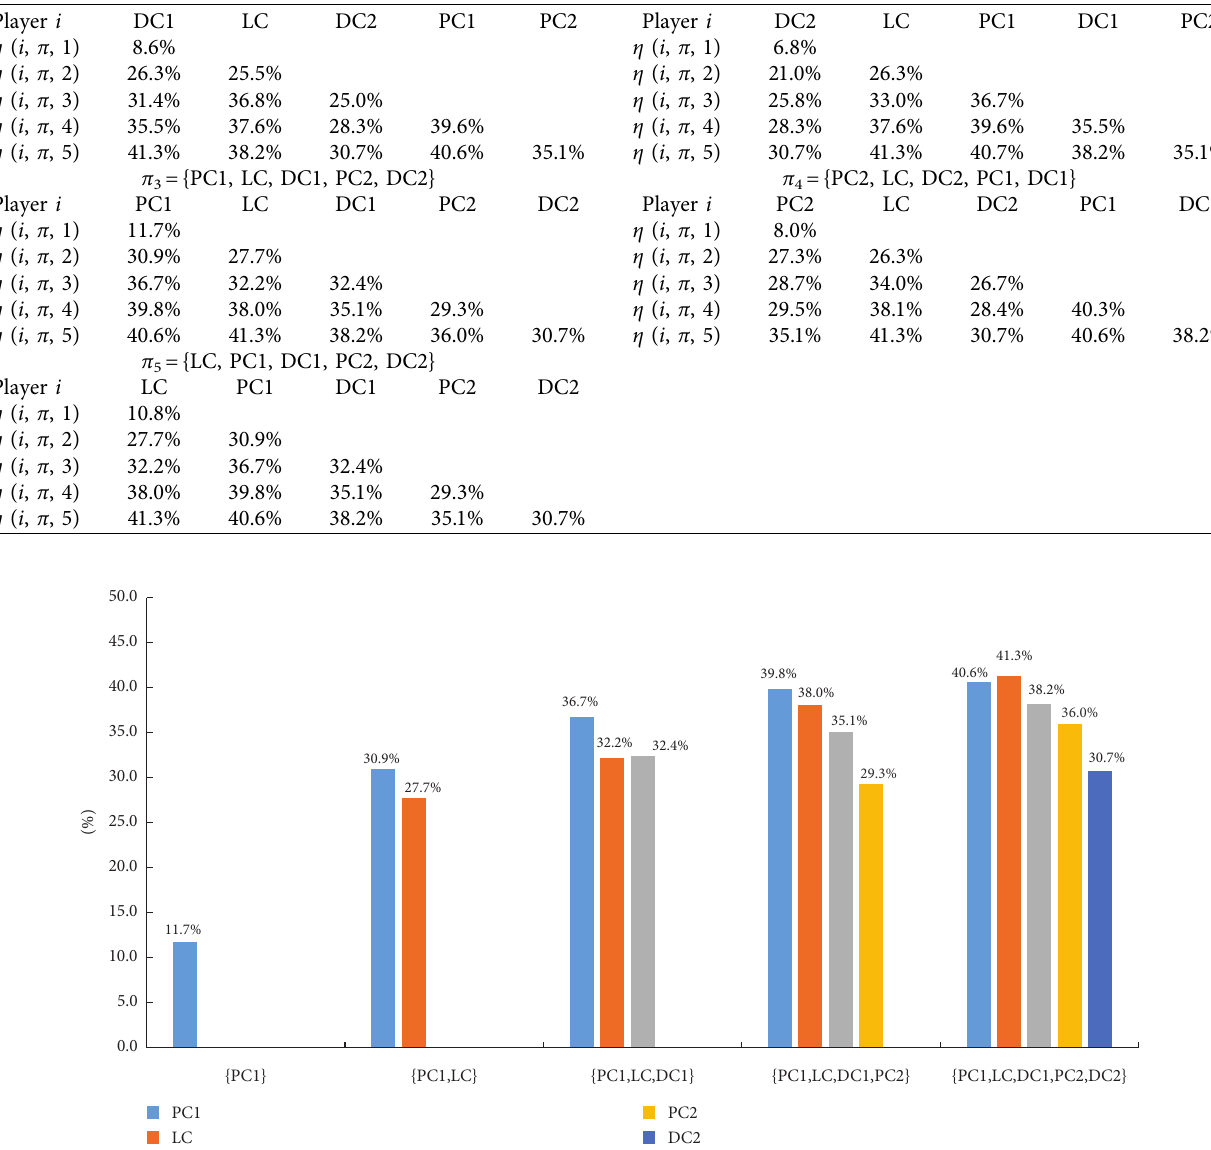
Figure 11: Cost reduction percentages of the grand